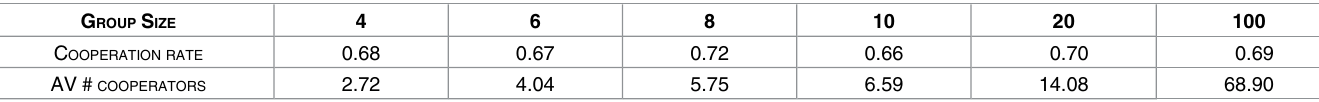
Table 1. Cooperation rate and averagenumber of